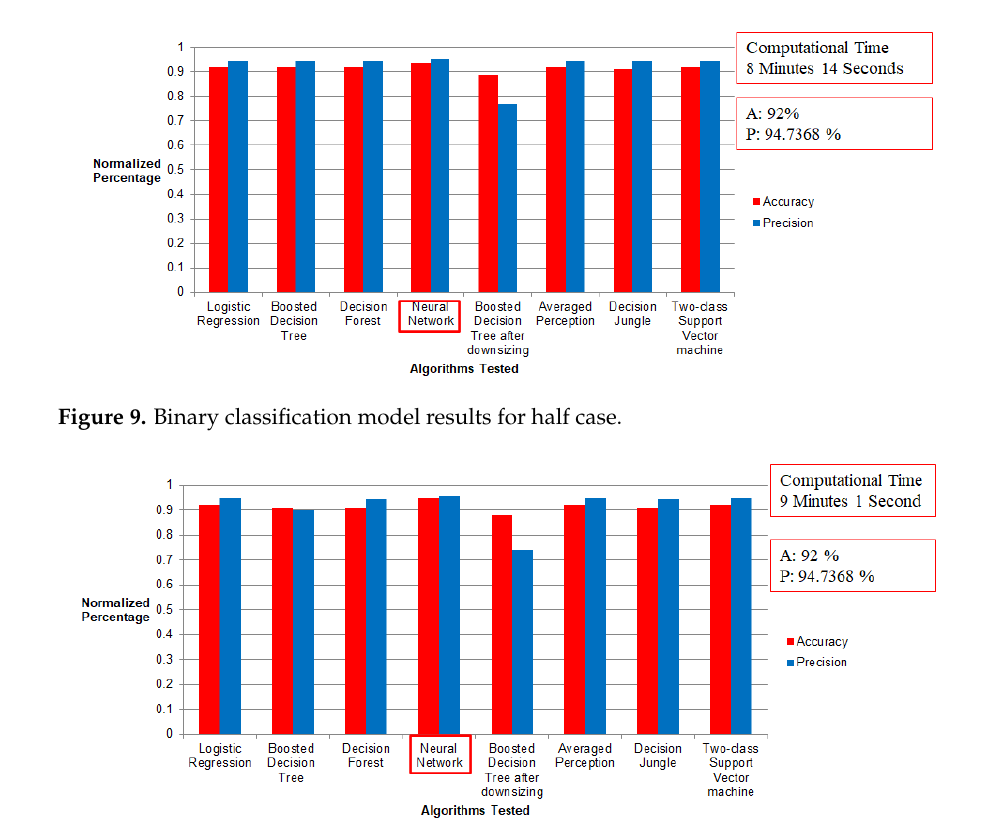
Figure 10. Binary classification model results for double case.